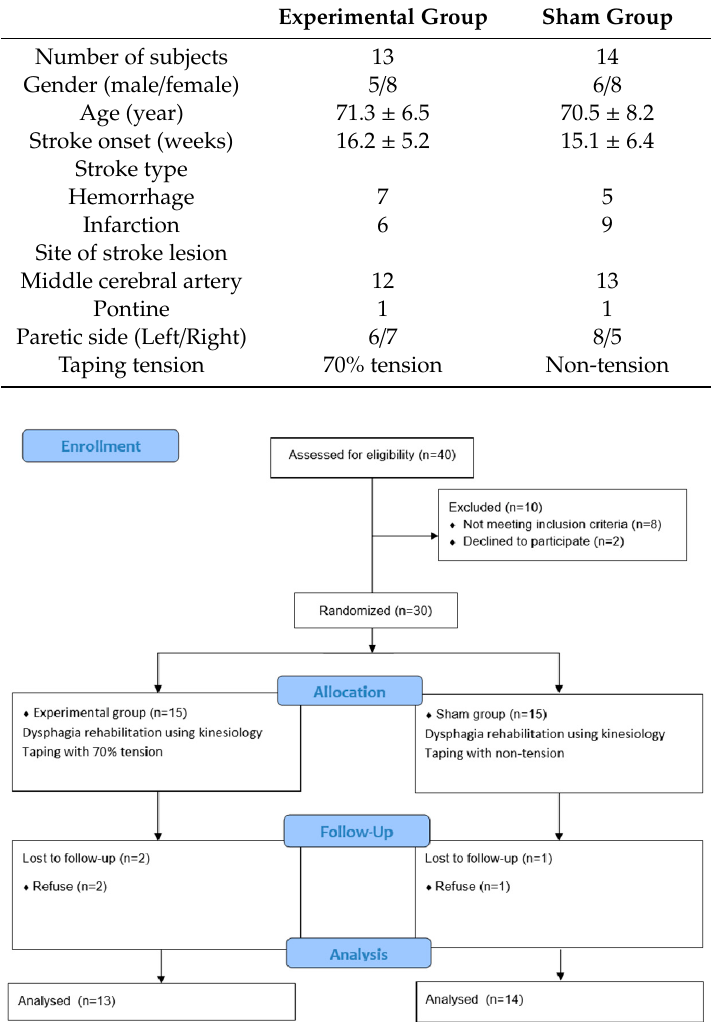
Table 1. General characteristics of the subjects.